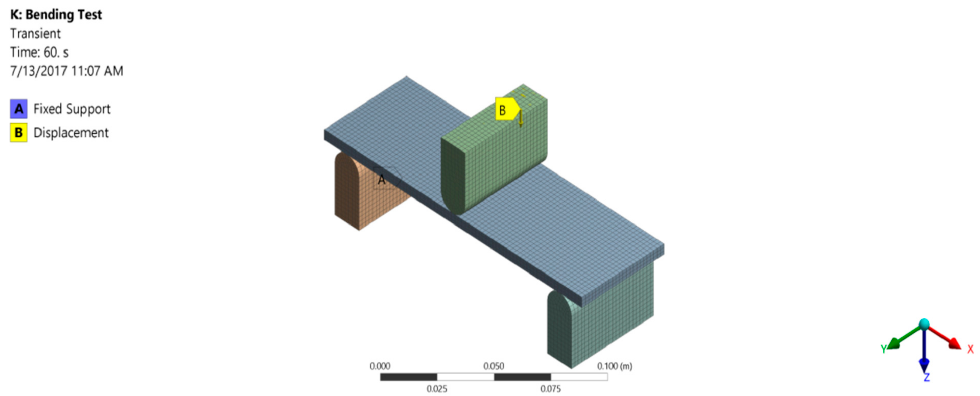
Figure 3. Isometric view of model with constraints used for the three-point flexure test simulation.